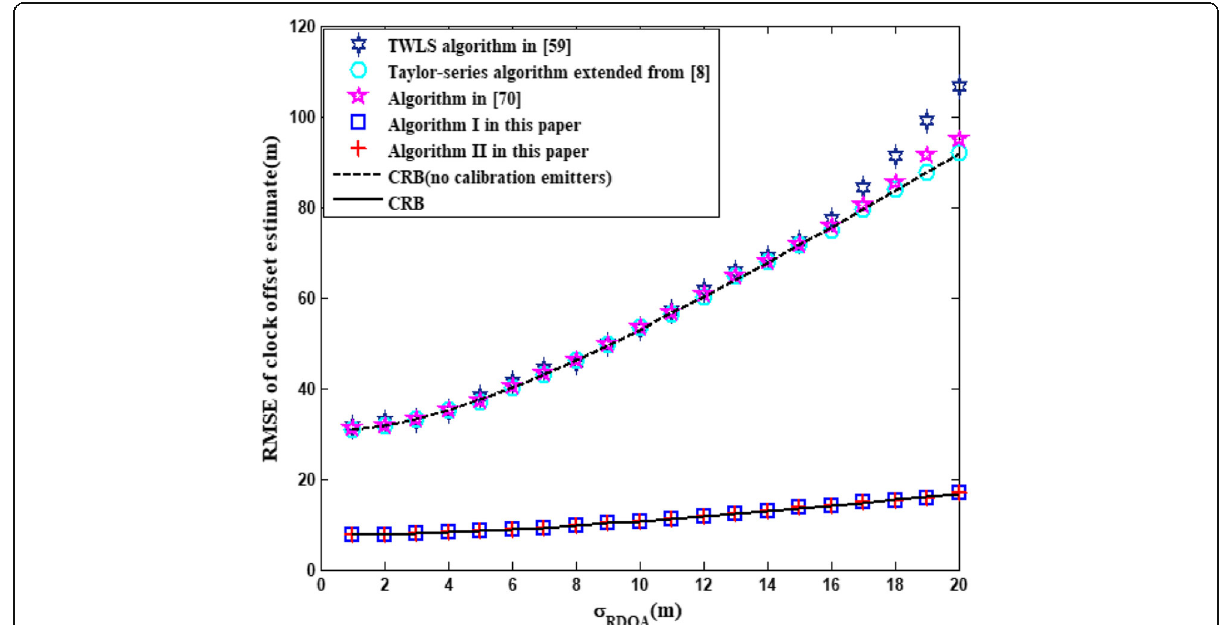
Fig. 8 RMSE of clock offset estimate versus σ